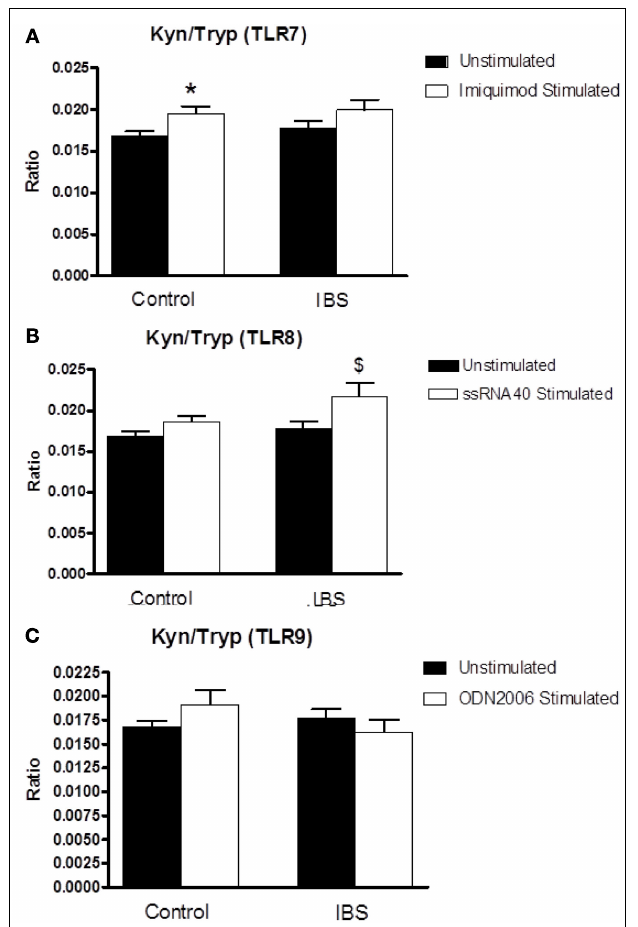
FIGURE 4 | Kynurenine:tryptophan (Kyn:Tryp) ratio in unstimulated whole blood supernatants from healthy controls and IBS patients and following stimulation with: (A)TLR 7 agonist Imiquimod, (B)TLR8 agonist ssRNA40, and (C)TLR9 agoinst ODN2006. Data are expressed as mean ± SEM. Statistical differences between treatments and disease states were determined using two-way ANOVA with Bonferroni post hoc test. * p < 0.05, Healthy control stimulated vs. unstimulated; $ p < 0.05, IBS stimulated vs.